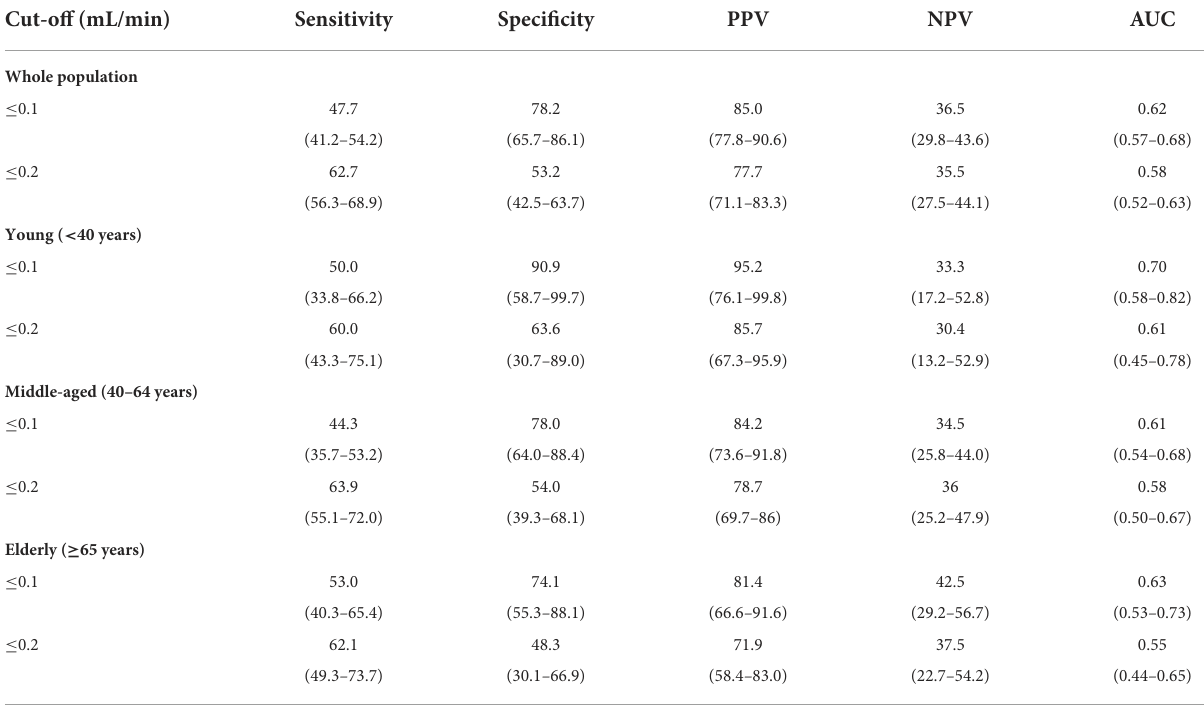
TABLE 2 Performance of the unstimulated salivary flow rate tests for diagnosing primary Sjögren’s syndrome according to age group. Cut-off